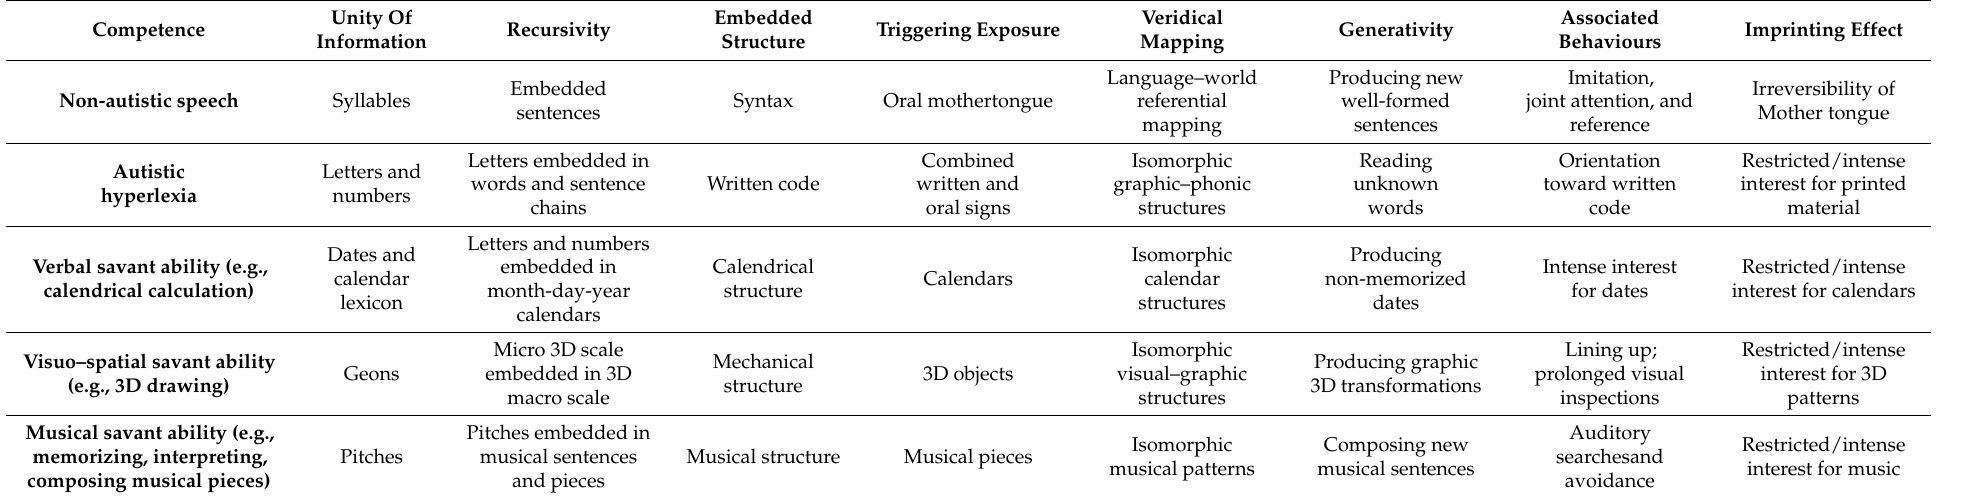
Table 1. Common unfolding of the non-autistic acquisition of oral language and autistic savant